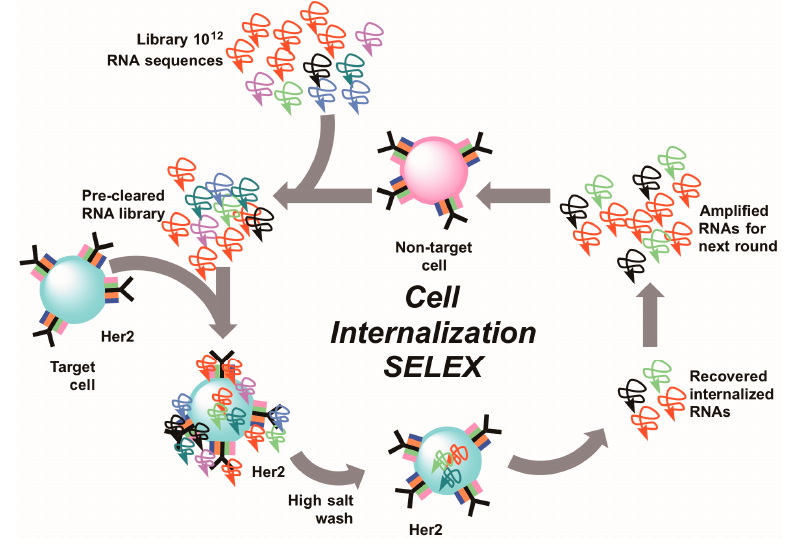
Figure 3. Schematic of cell-internalization SELEX. Cell-internalization SELEX was designed to isolate ssRNA sequences exclusively based on their capacity to bind the cell-surface target and their ability to rapidly internalize the cell in physiological conditions, while effectively eliminating aptamers that lack internalizing ability and aptamers that only slowly internalize into the cells.